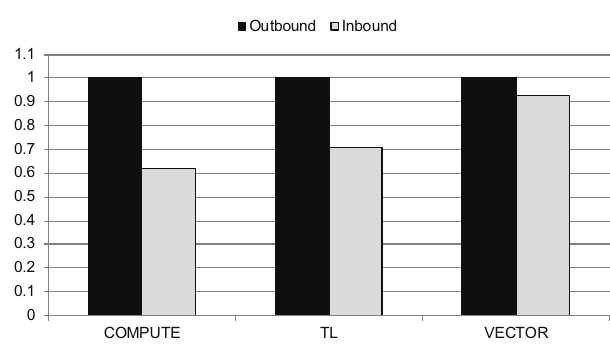
Figure 13. Inbound mailbox